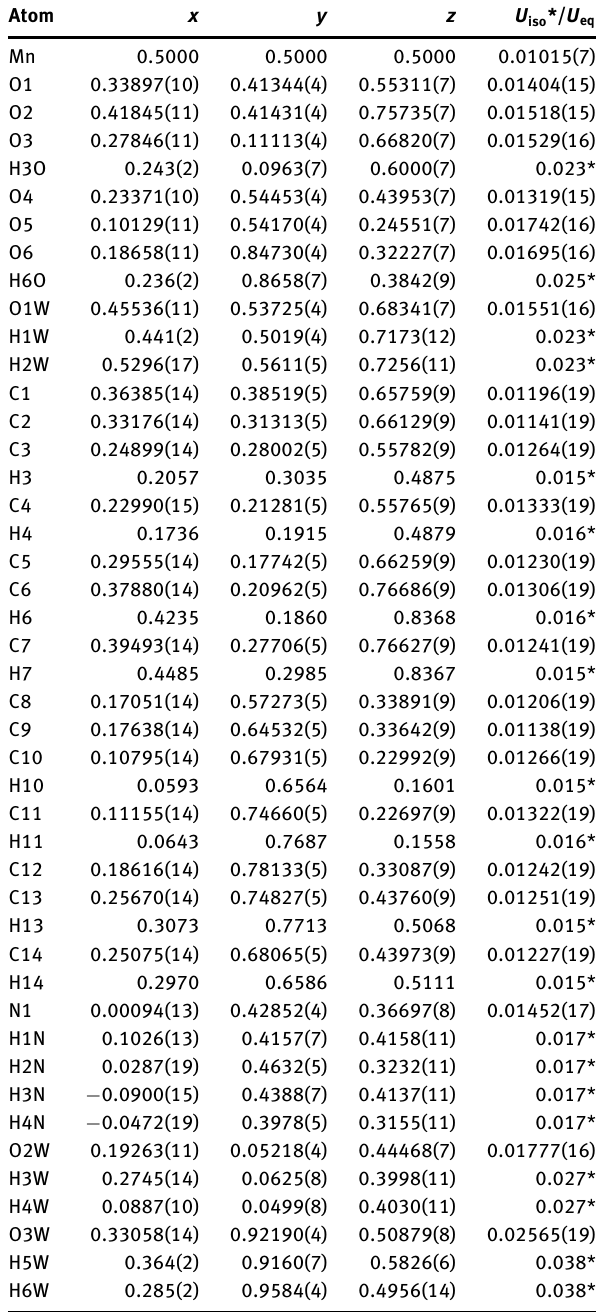
Table 2: Fractional atomic coordinates and isotropic or equivalent isotropic displacement parameters (Å 2